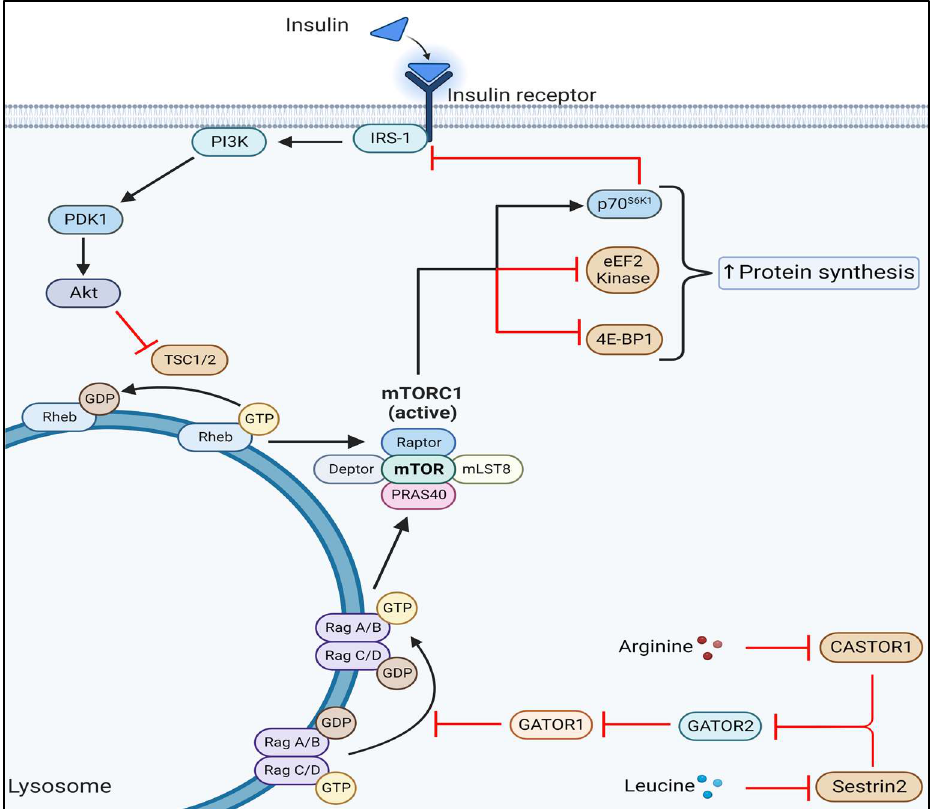
Figure 1. Activation of mTORC1 by growth factors and amino acids. Activation of mTORC1 requires the integration of extracellular and intracellular signals. Binding of insulin to the insulin receptor induces a cascade of signaling events that culminate in Akt-mediated inhibition of TSC1/2. Phosphorylation of TSC1/2 by Akt prevents TSC1/2 GAP activity towards RHEB, allowing for activation of mTORC1. In response to amino acid availability, CASTOR1 and Sestrin2 inhibition of GATOR2 is relieved, allowing for GATOR2 inhibition of GATOR1. Inhibition of GATOR1 allows for Rag-mediated activation of mTORC1. Phosphorylation of p70 S6K1 , 4e-BP1- and eEF2 kinase